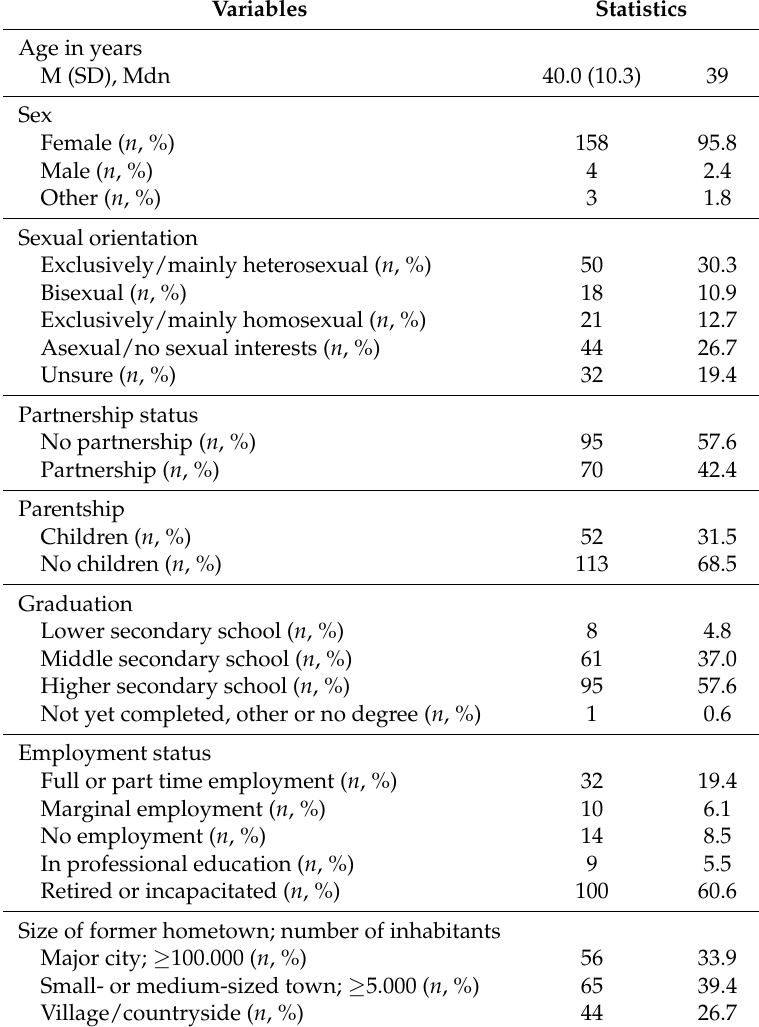
Table 1. Socio-demographic sample characteristics of self-identified ORA victims ( n =